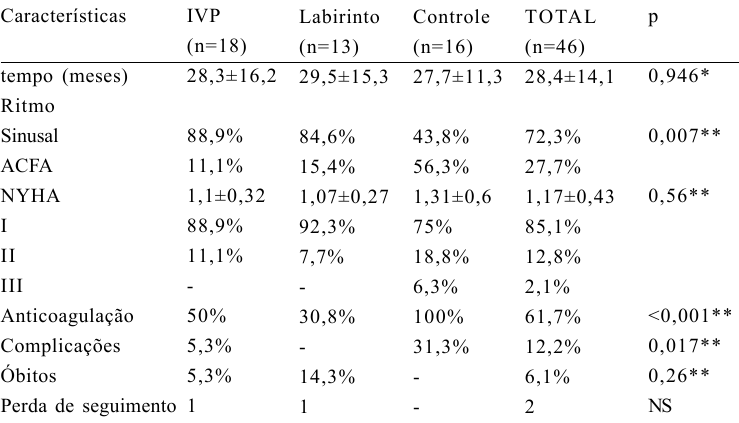
Tabela 3. Seguimento dos pacientes.